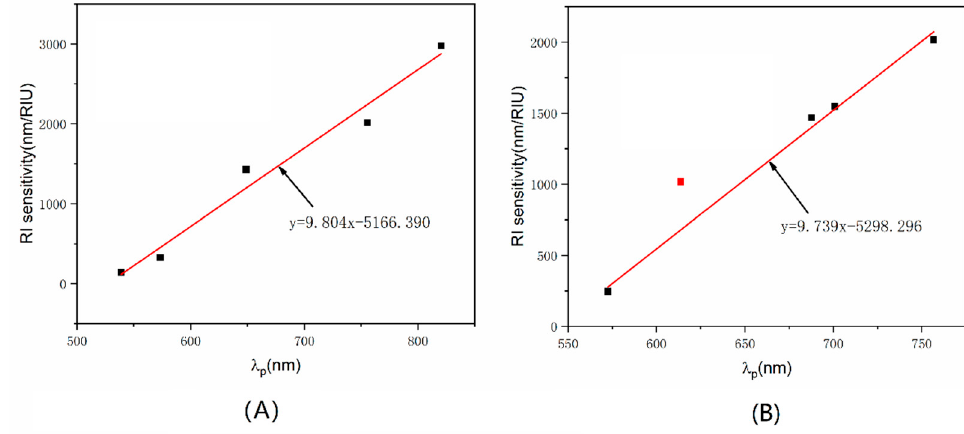
Figure 7. Linear fitting between S RI and λ p for ( A ) different sizes and ( B ) different densities (red square point outlier did not participate in the fitting).